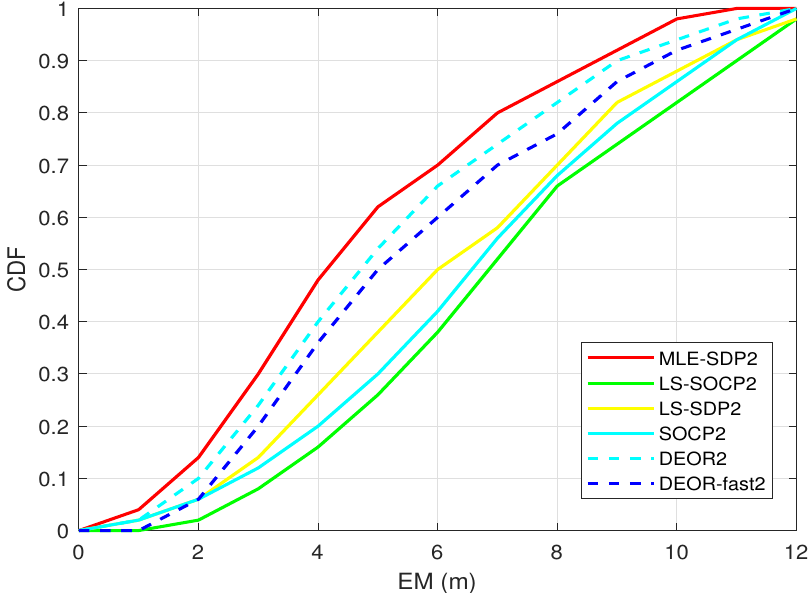
Figure 9. The CDF of the